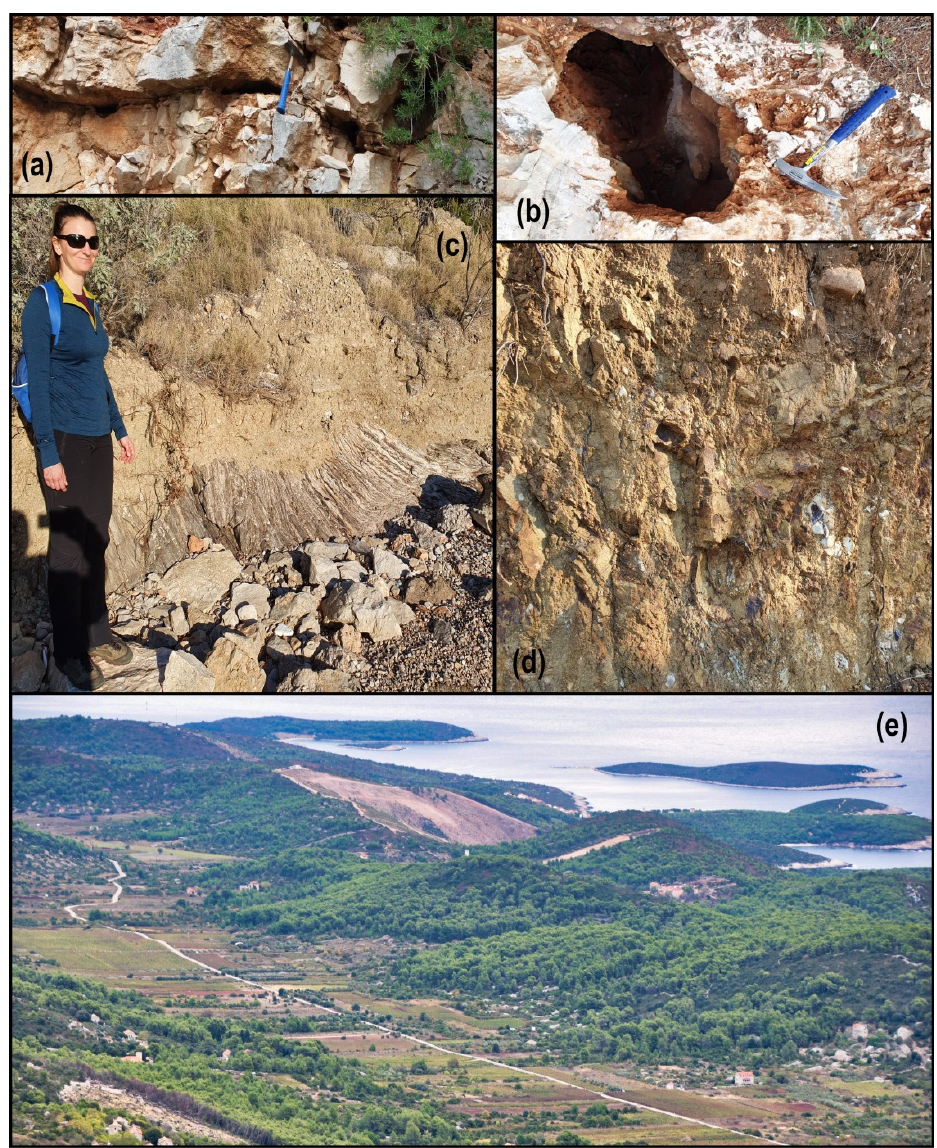
Figure 5. Specific features on Vis Island: ( a ) typical appearance of limestone rock mass in the central part; ( b ) karst conduit in the immediate vicinity of the Korita pumping site; ( c ) gypsum and anhydrite in the VSE complex near the Pizdica spring; ( d ) weathered volcanic agglomerate in the VSE complex near the Kamenice spring; ( e ) panoramic view of karst poljes in the southern tectonic valley.